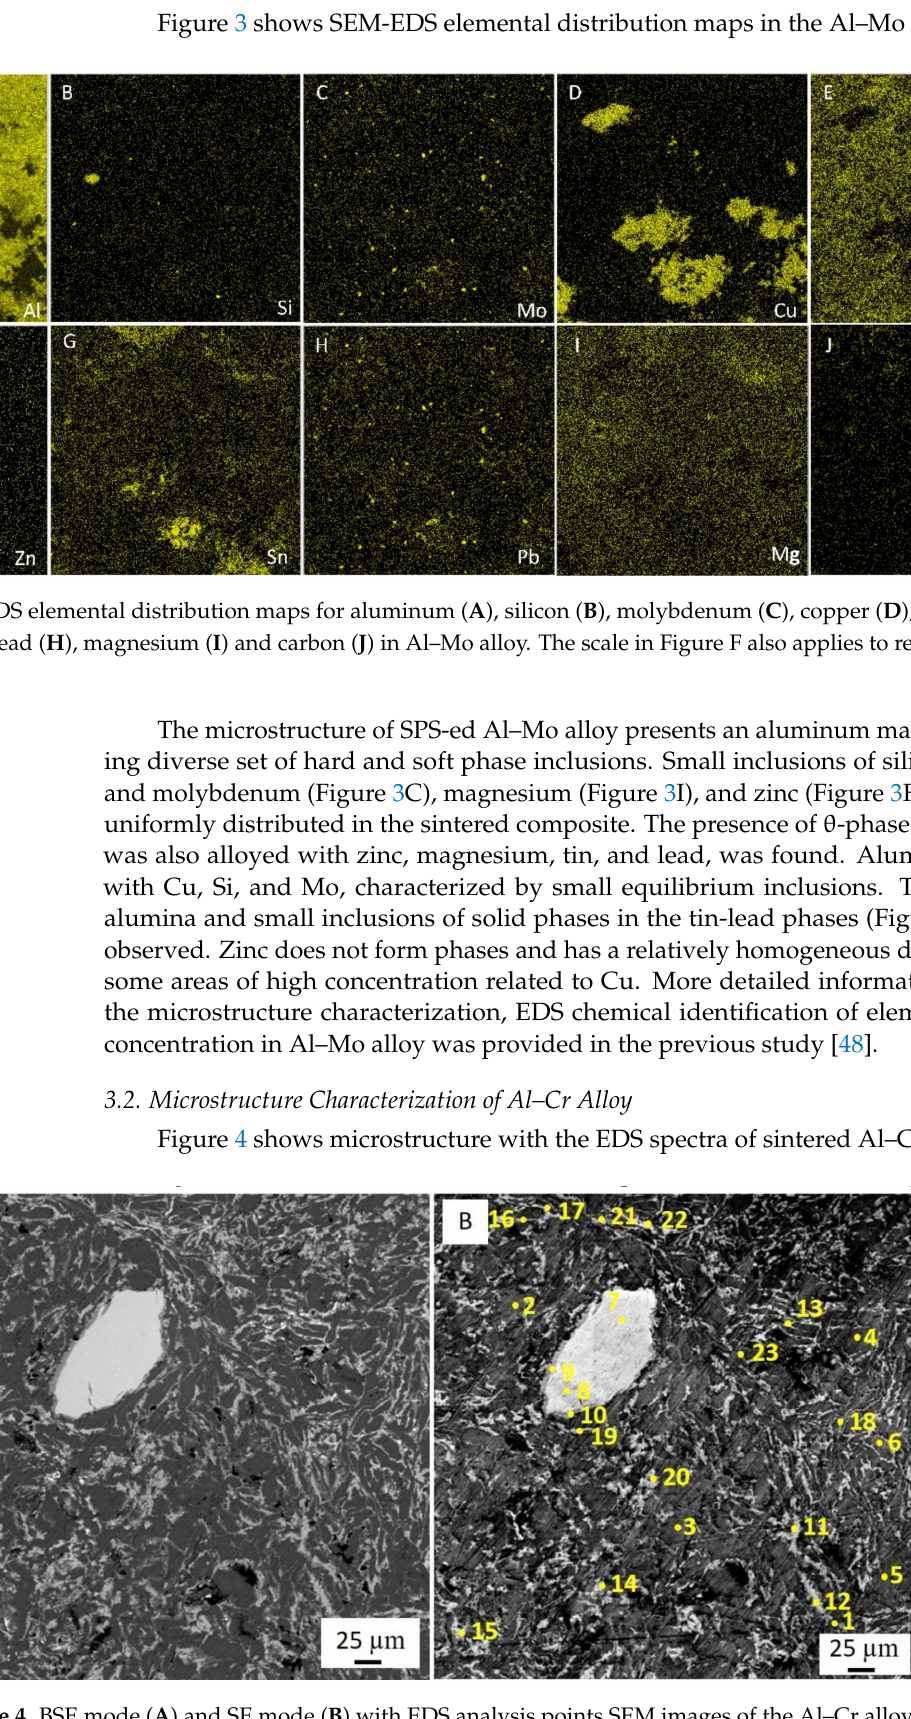
Figure 4. BSE mode ( A ) and SE mode ( B ) with EDS analysis points SEM images of the Al–Cr